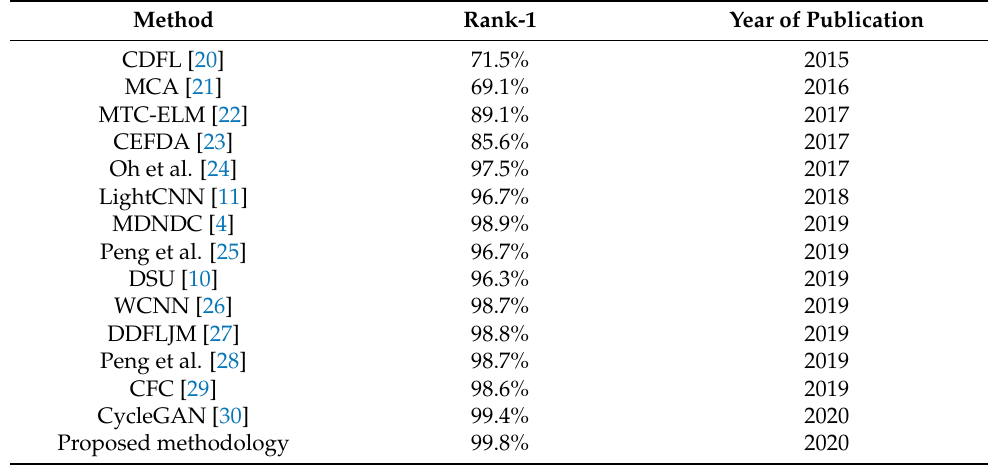
Table 5. Results obtained through the proposed methodology when compared with the state-of-the- art for the CASIA NIR-VIS 2.0